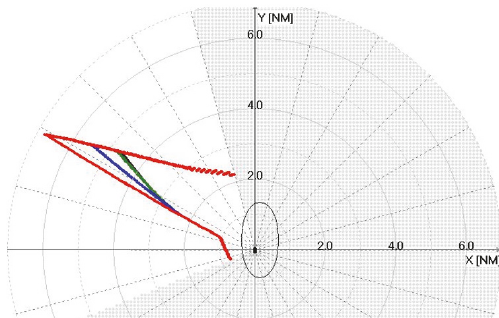
Figure 20: Action lines for stand-on crossing encounter with a target, whose true speed is 23 knots. Assumed are turns of 65 ∘ to starboard without speed reduction (red) or with speed reduced by 3 knots (blue), 6 knots (green), and 9 knots